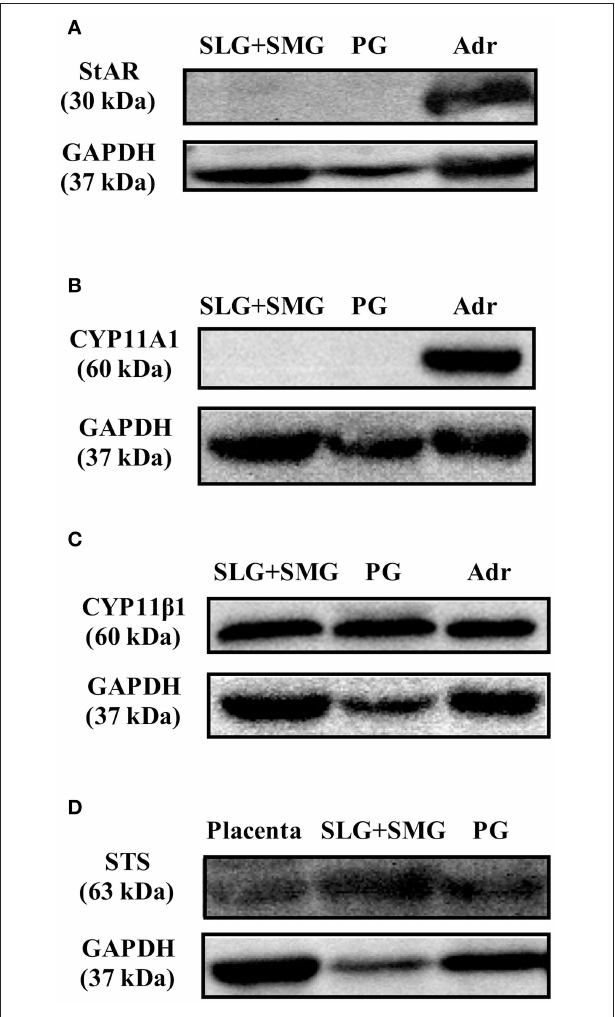
FIGURE 5 | Western blotting analysis of (A) steroidogenic acute regulatory (StAR) protein expression, (B) CYP family 11 subfamily A member 1 (CYP11A1) protein expression, and (C) cytochrome P450 11 β (CYP11 β 1) protein expression in rat sublingual gland and submandibular gland (SLG + SMG), parotid gland (PG), and adrenal gland (Adr) using respective antibodies. (D) Western blotting analysis of steroid sulfatase (STS) protein expression in rat SLG + SMG, PG, and placenta using anti–steroid sulfatase antibody. Each protein was analyzed three times, and representative results are